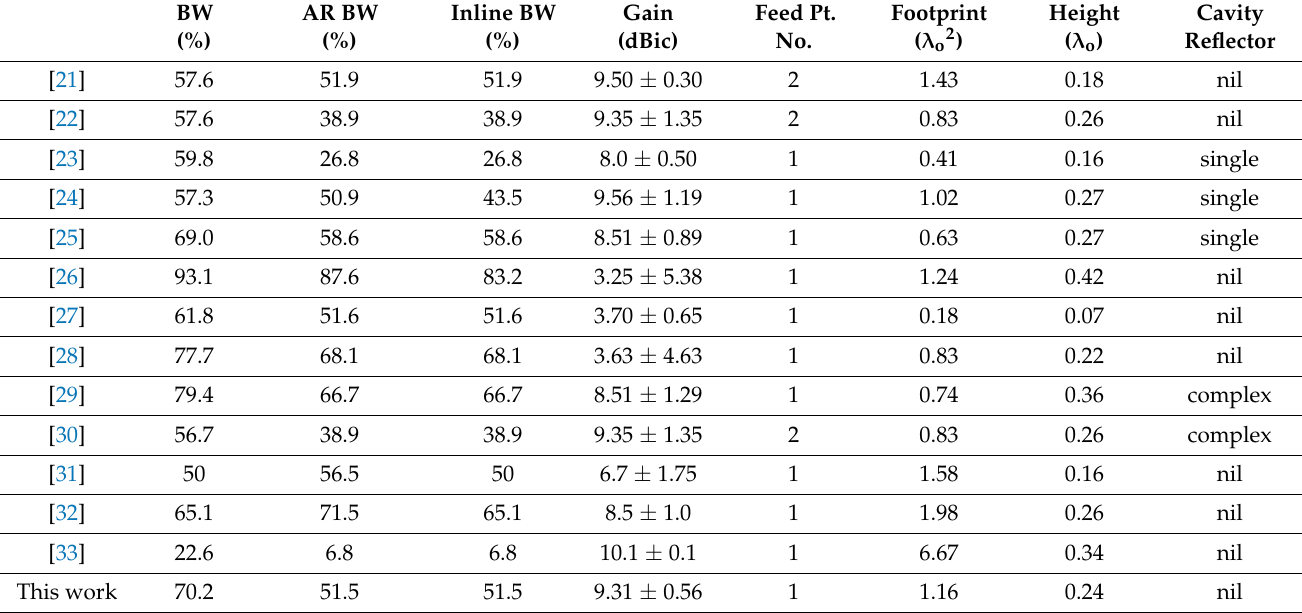
Table 1. Comparison of measured results of recently reported wideband circular polarized